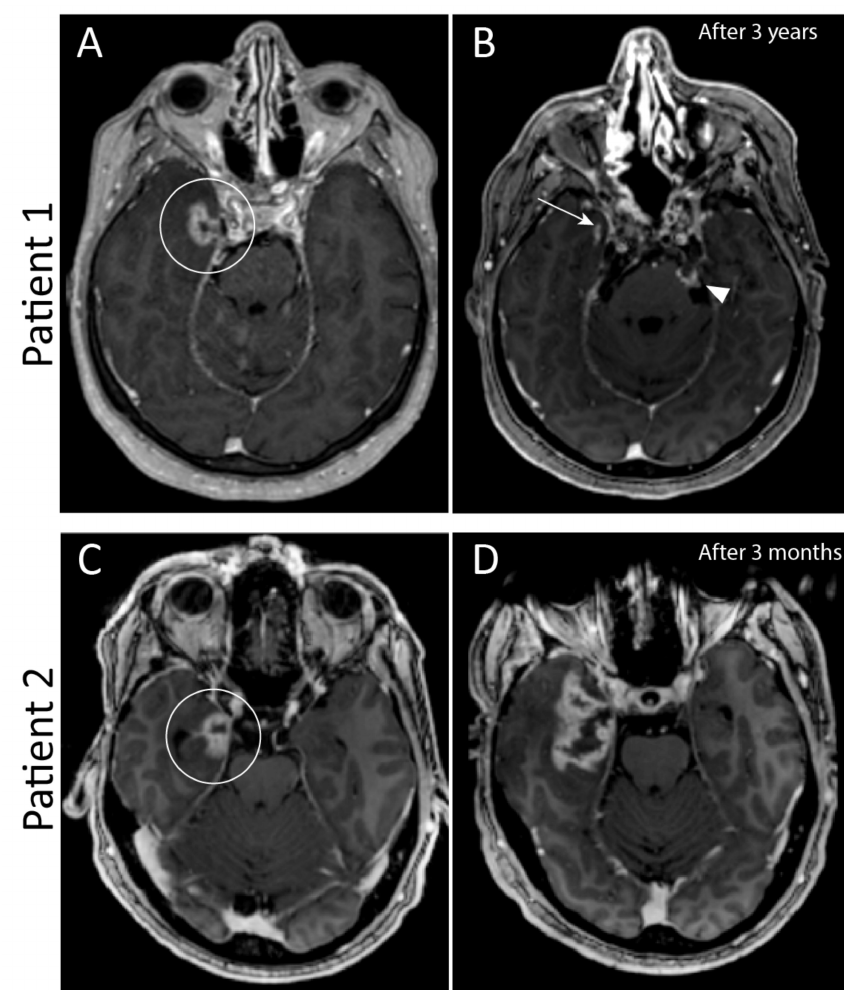
Figure 4. Two patients with similar contrast enhancement of the medial temporal lobe three years after radiotherapy in patient 1, and one year after radiotherapy in patient 2 (circled in ( A , C )). This contrast enhancement is consistent with either radiation necrosis or tumor progression. In ( A ) there are also hyperintense foci in the upper cerebellum, which are due to phase encoded pulsation artefacts of the carotid artery on both sides and not a true enhancement. Follow-up imaging after three months showed no differences in patient 1, and imaging after 3 years ( B ) showed clear regression of enhancement of the temporal lobe (arrow). However, this patient had tumor progression in the clivus and cerebellopontine cistern on the left side (arrowhead). In patient 2, follow-up imaging after three months ( D ) showed clear progression in enhancement and mass effect. Tissue biopsy confirmed that this was tumor